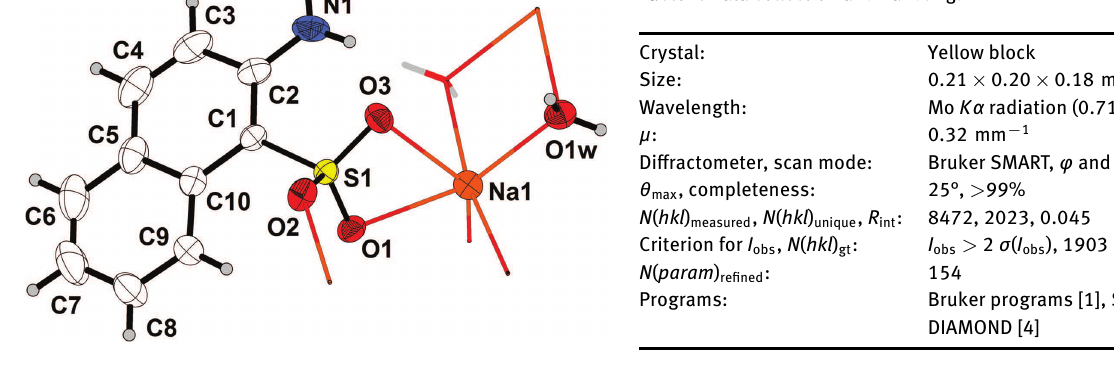
Table 1: Data collection and handling.